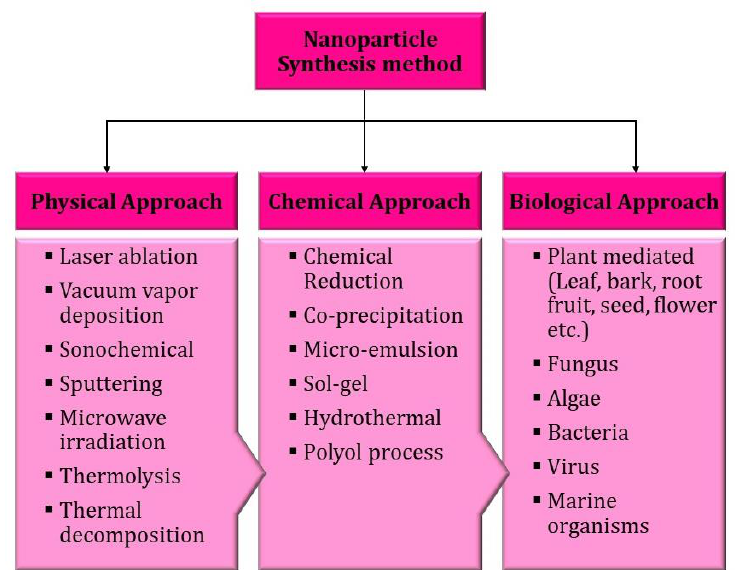
Fig. 2. Diverse synthetic approaches involved in the production of nanomaterials